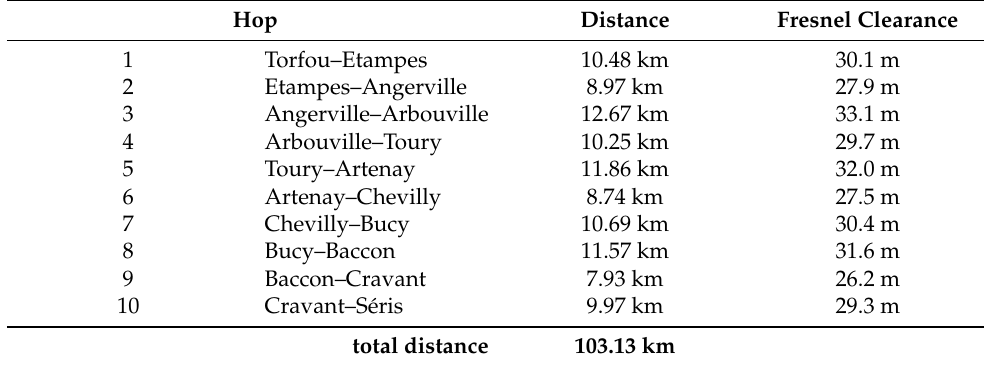
Table 1. Length of each hop in the network.